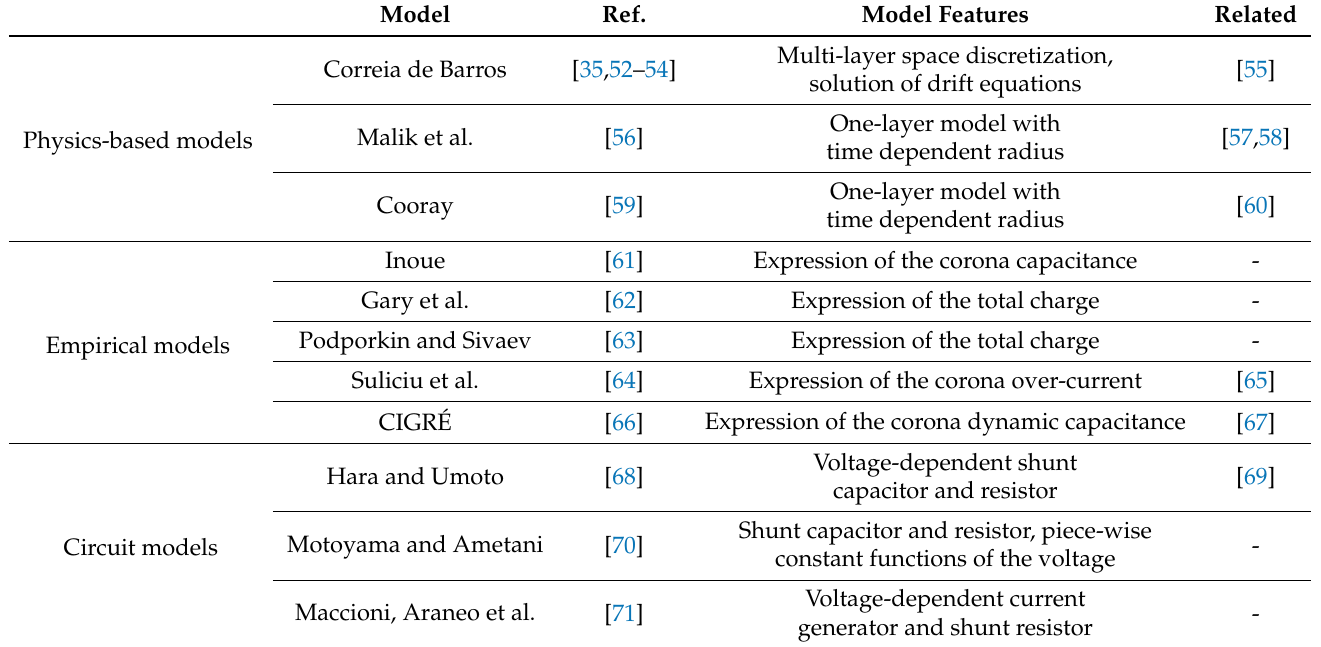
Table 1. Main models for corona effect